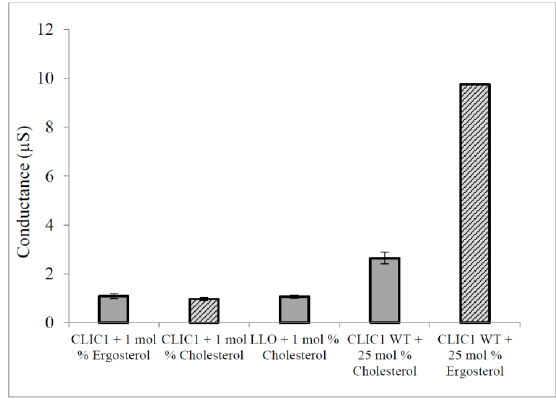
Figure 7. Conduction of pre-incubated CLIC1 monomer with sterols in tBLMs containing 50 mol % cholesterol or ergosterol. CLIC1 (WT) monomeric protein (20 µg in 100 µL of HEPES/KCl buffer, pH 6.5) was incubated with 1% cholesterol or 1% ergosterol for ~1 h prior addition to tethered bilayer lipid membranes containing 25 mol % cholesterol or ergosterol. Conductance of pre-incubated CLIC1 monomer with sterols was then measured with impedance spectroscopy and compared to Controls: CLIC1 monomer not pre-incubated with sterols added into membranes containing 1% of cholesterol or ergosterol, listeriolysin-O (20 µg of LLO in 100 µL of HEPES/KCl buffer, pH 6.5) was also incubated with 1% cholesterol under the same conditions as CLIC1 monomer followed by addition to membranes with 50 mol % cholesterol. The error bars represent the standard error of three repeats of experimental measures ( n = 3).